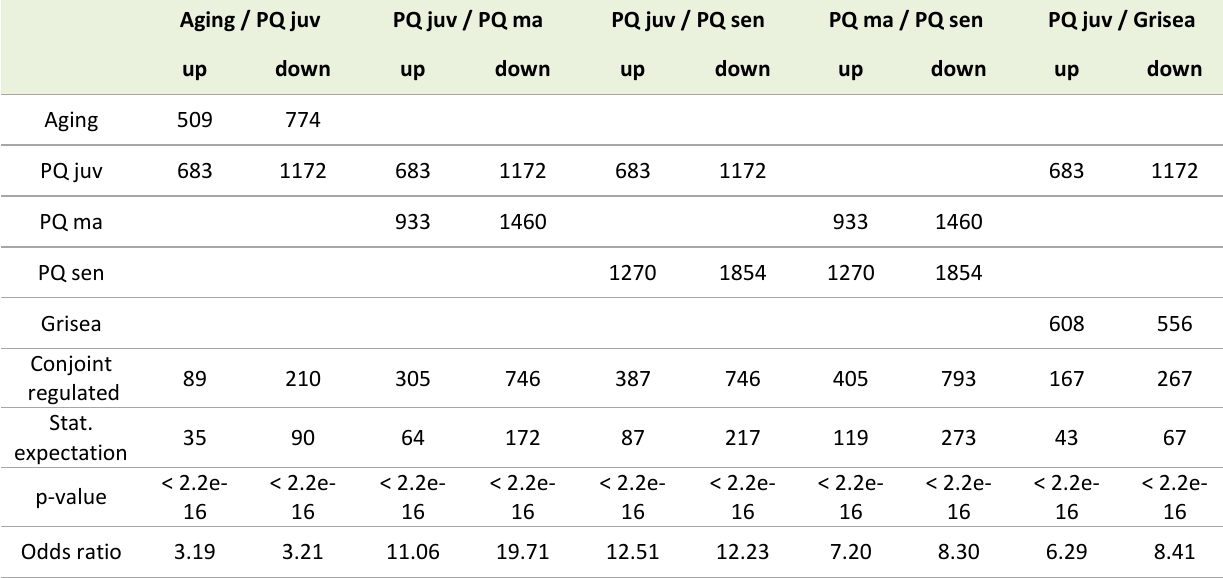
TABLE 1. Global gene regulation in the P. anserina wild type stressed by PQ and during aging. Aging / PQ juv PQ juv / PQ ma PQ juv / PQ sen PQ ma / PQ sen PQ juv / Grisea up down up down up down up down up down Aging 509 774 PQ